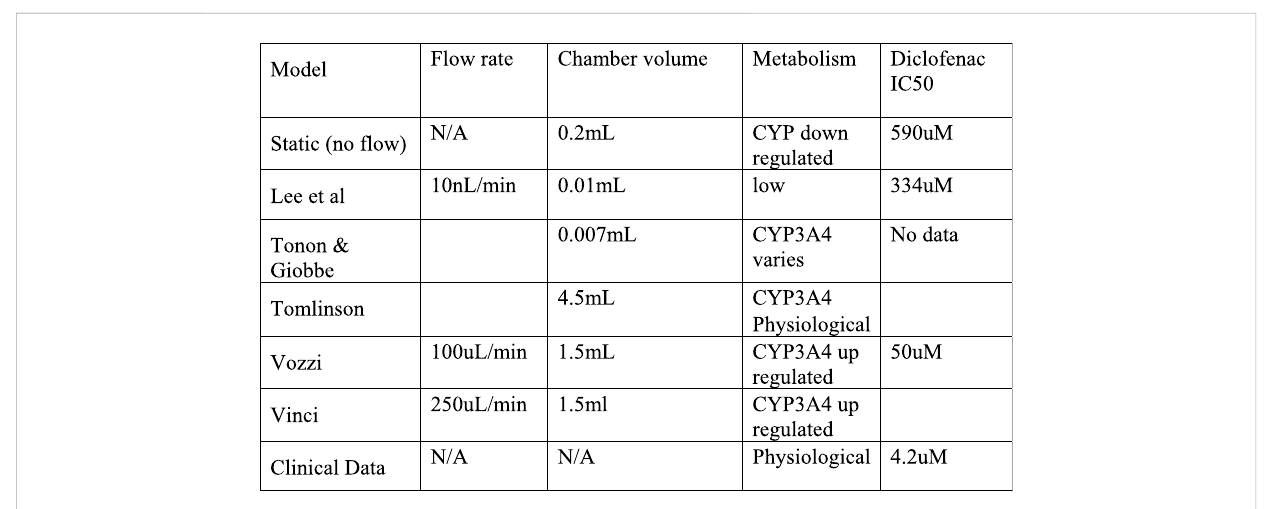
FIGURE 5 Sensitivity vs. Speci fi city for Assays.